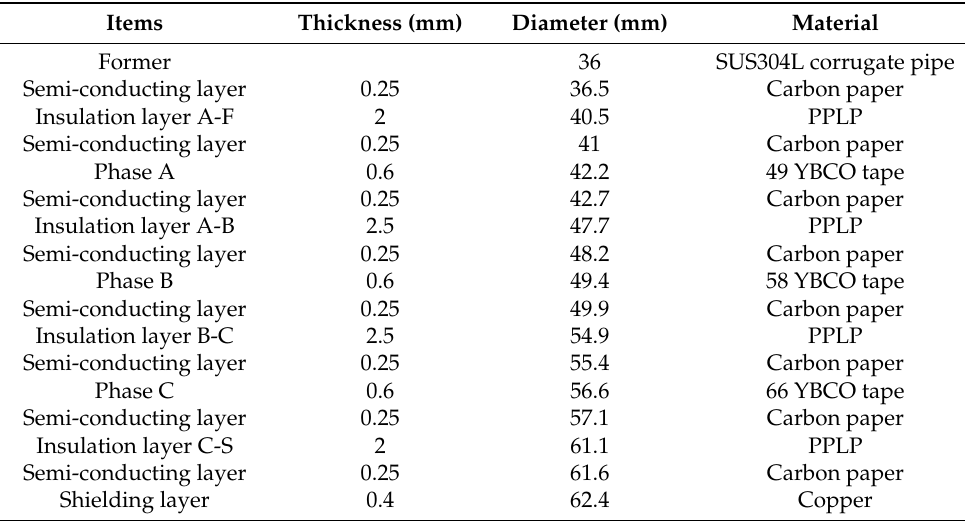
Table 1. Specifications of the cable conductor.